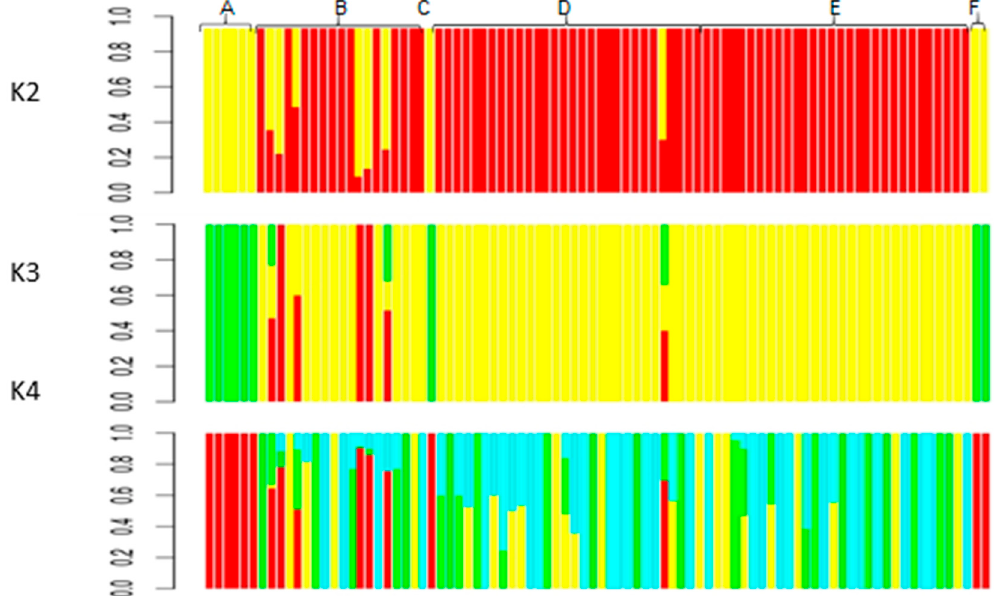
Figure 1. Genetic structure of 88 plants representing seven forage oat genotypes (A = Cajicá and Cayuse, commercial varieties), B = AV25-C, the mixed source population, C = AV25-P, the early selection D = AV25-S, mass selection samples from Sutacón, E = AV25-T mass selection samples from Tibaitatá and F = AV25-Ta, the late selection. Each individual panel is divided into subgroups coded in colors based on clustering K -value from 2 to 4 being the number of groups assumed. Length of the bar segment represents the estimated proportion of sample membership.